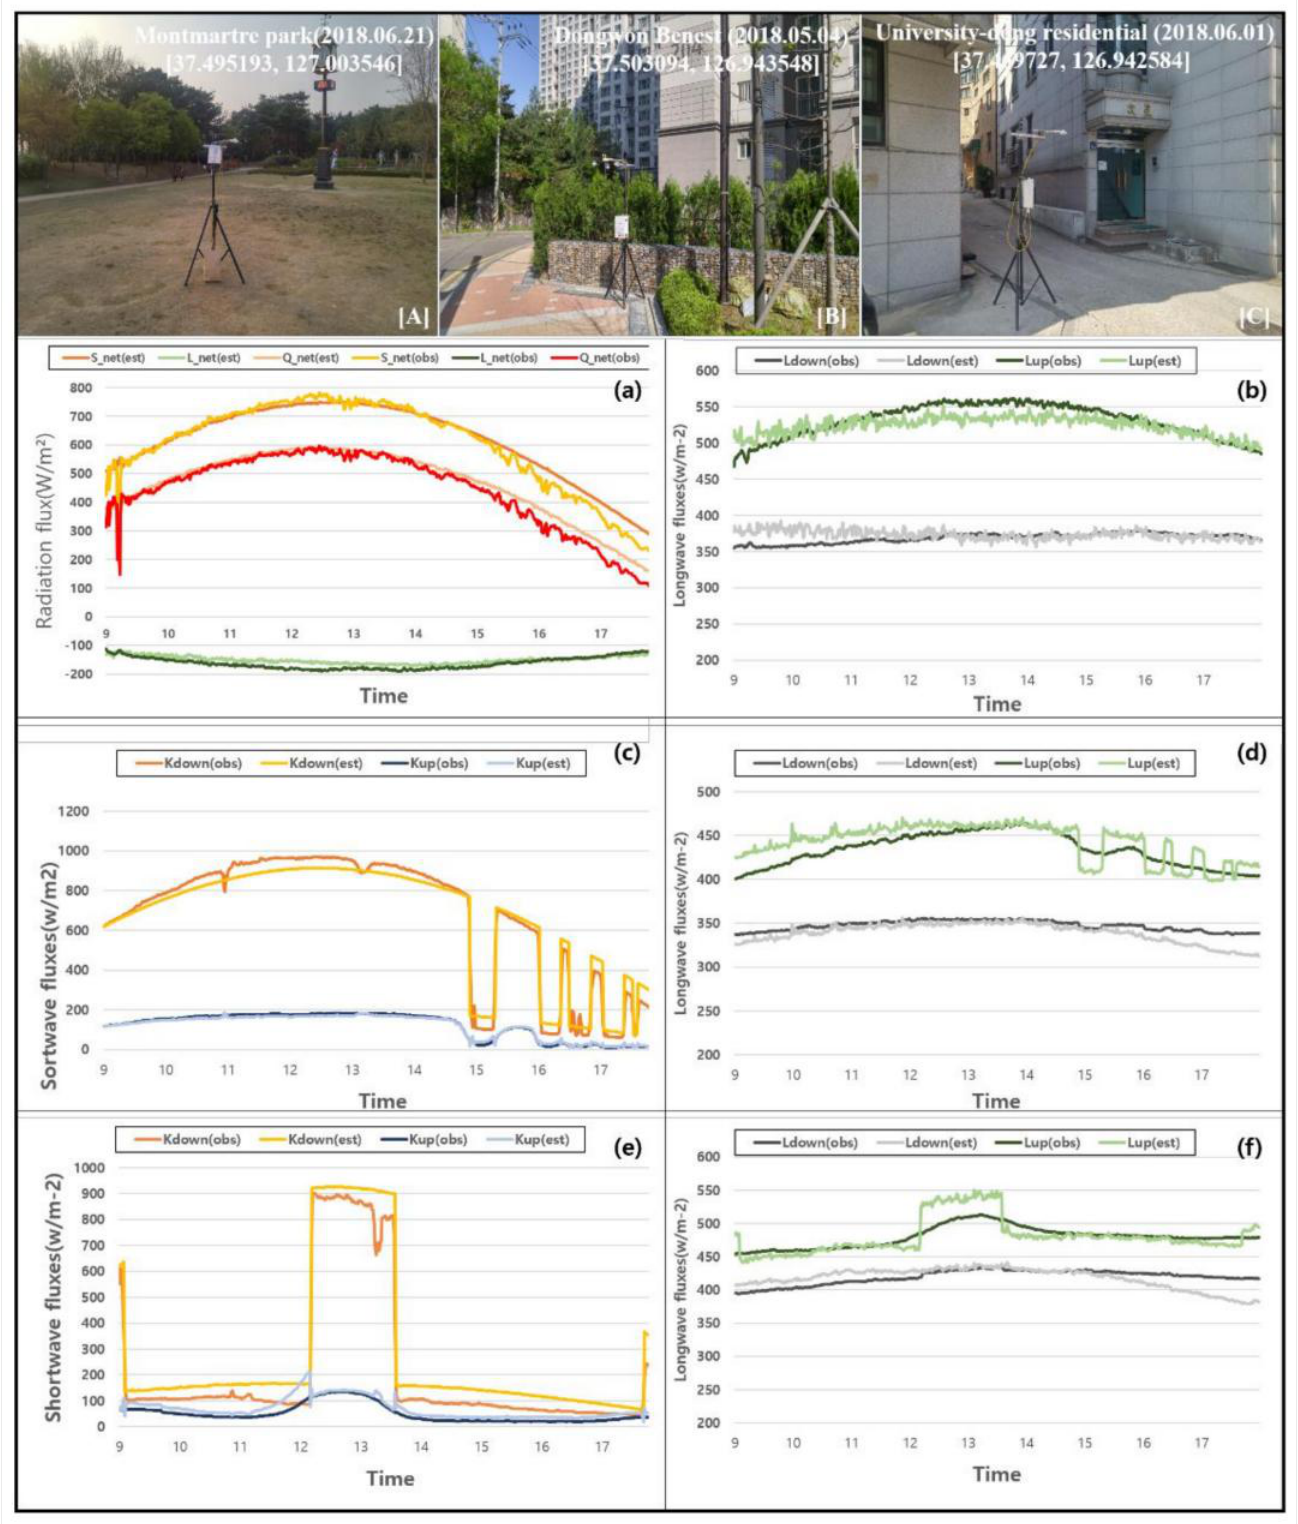
Figure A2. The clear-sky solar radiance of street canyons for a day in high-density and low-building environments in various places. ( A ) Montmartre park ( B ) Dongwon Benest ( C ) University. Compari- son between measurement and estimated radiation ( a )–( f